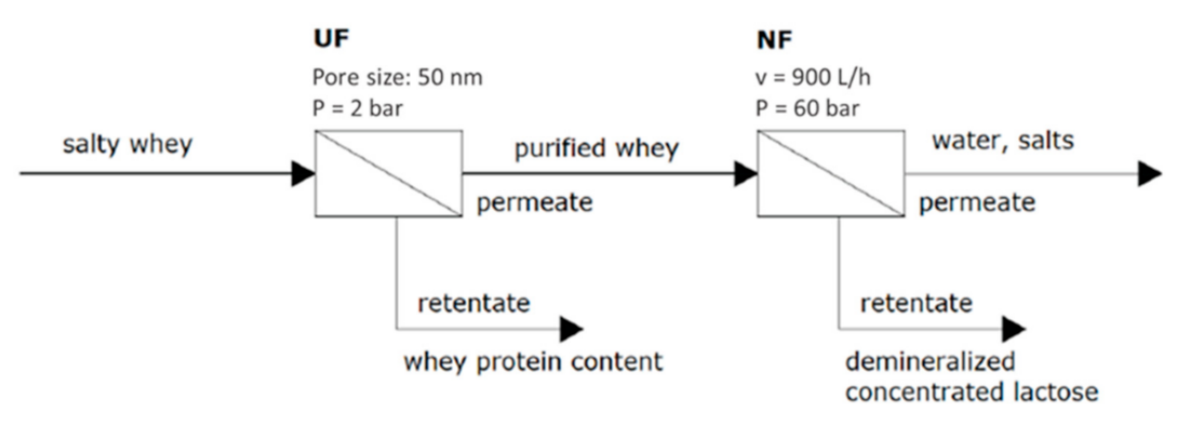
Figure 10. Demineralization of a high-lactose-content stream by integration of UF and MF. In that work, a tubular ceramic UF membrane (MWCO 500 nm) provided by Mem- bralox (Pall, New York, NY, USA) was used to treat whey by applying a constant transmem- brane pressure of 2 bar. Then, the UF permeate was purified by NF at 60 bar and 900 L/h (maximum flow rate), using two different spiral-wound membranes, NTR-7450-S2F (Nitto Denko, Osaka, Japan) and FILMTEC NF270 (Dupont, Delaware, DE, USA), with polyamide as an active membrane